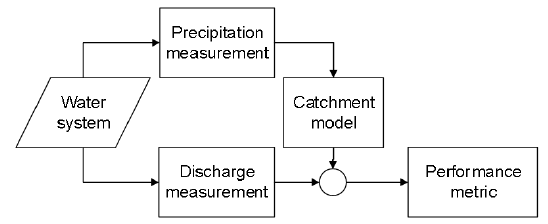
Figure 4. General procedure for model-based sensor network eval-